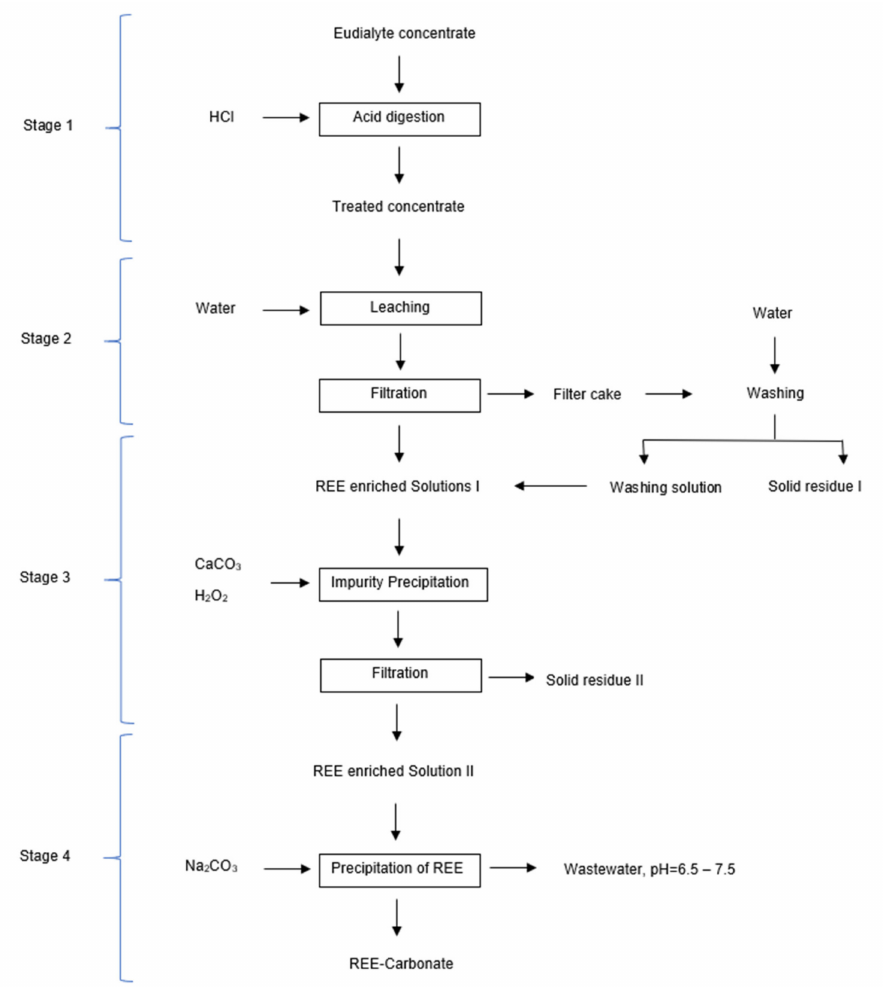
Figure 4. Treatment of eudialyte concentrate with hydrochloric acid at room temperature.